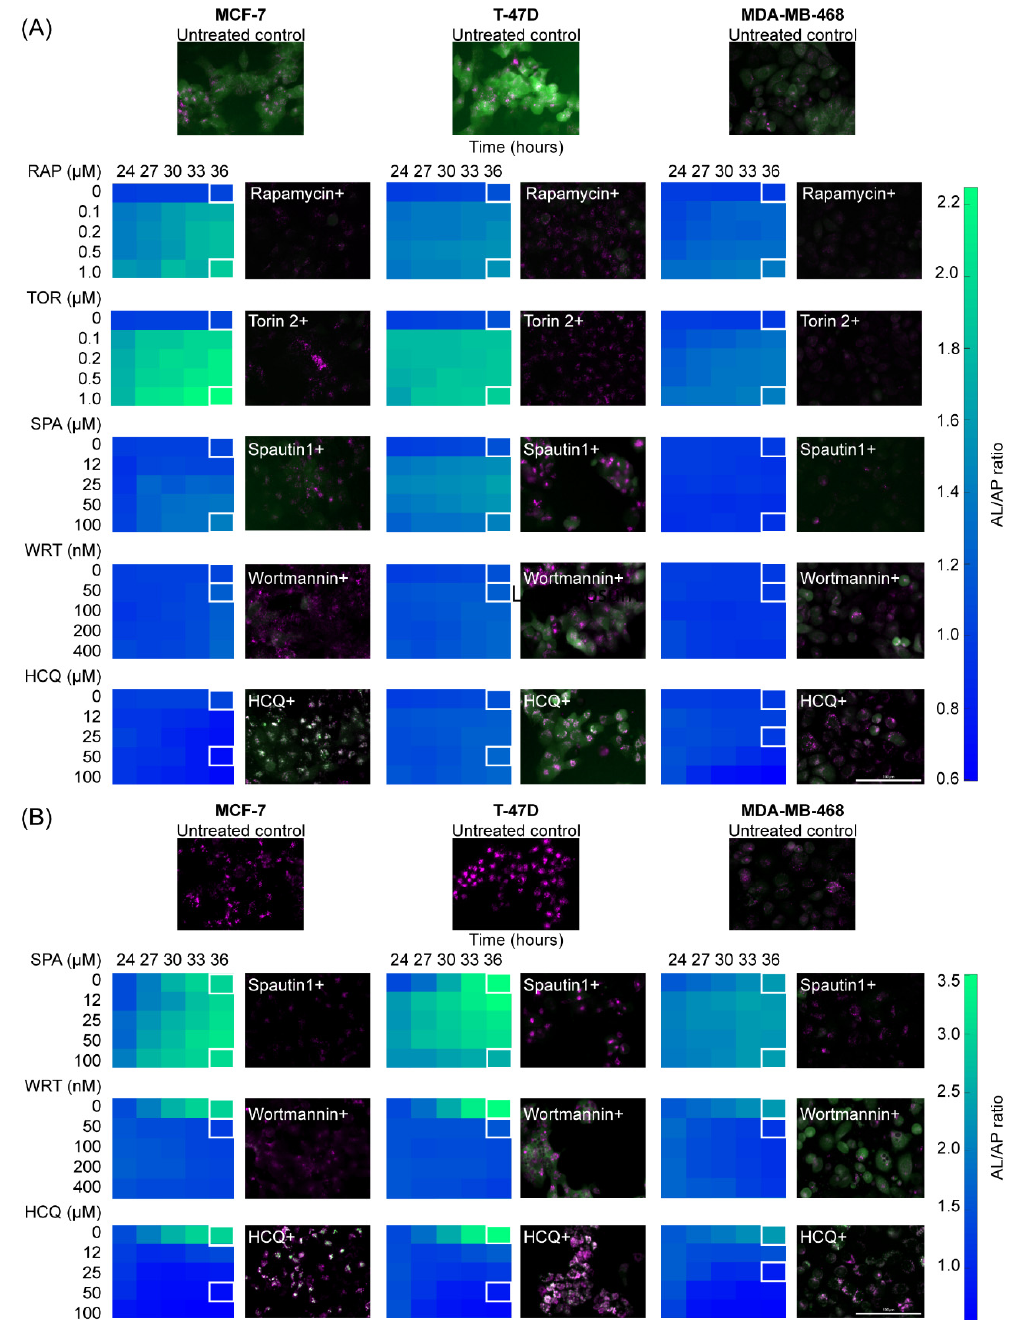
Figure 2. Breast cancer cell lines display a heterogeneous response to perturbations of the autophagic flux. ( A ) Variations in the autophagy sensor were monitored in three breast cancer cell lines upon different autophagy regulators treatment in the supplemented medium. RAP, TOR and SPA effect over the autophagy flux was measured after 24 h of treatment of the respective drug, then the medium was replaced with new supplemented culture medium containing the respective same drug concentration. WRT and HCQ activities over the autophagy flux are immediate, for that reason their effect over this pathway was quantified immediately upon treatment. ( B ) Variations in the autophagy sensor were monitored in three breast cancer cell lines upon different autophagy regulators treatment in starvation medium. SPA treatment began 24 h before the kinetic assay, then the supplemented medium containing this treatment was replaced with a starvation medium containing the same drug dose. No pretreatment was performed with WRT and HCQ. HCQ: hydroxychloroquine, RAP: rapamycin, SPA: Spautin-1, TOR: Torin-2, WRT: